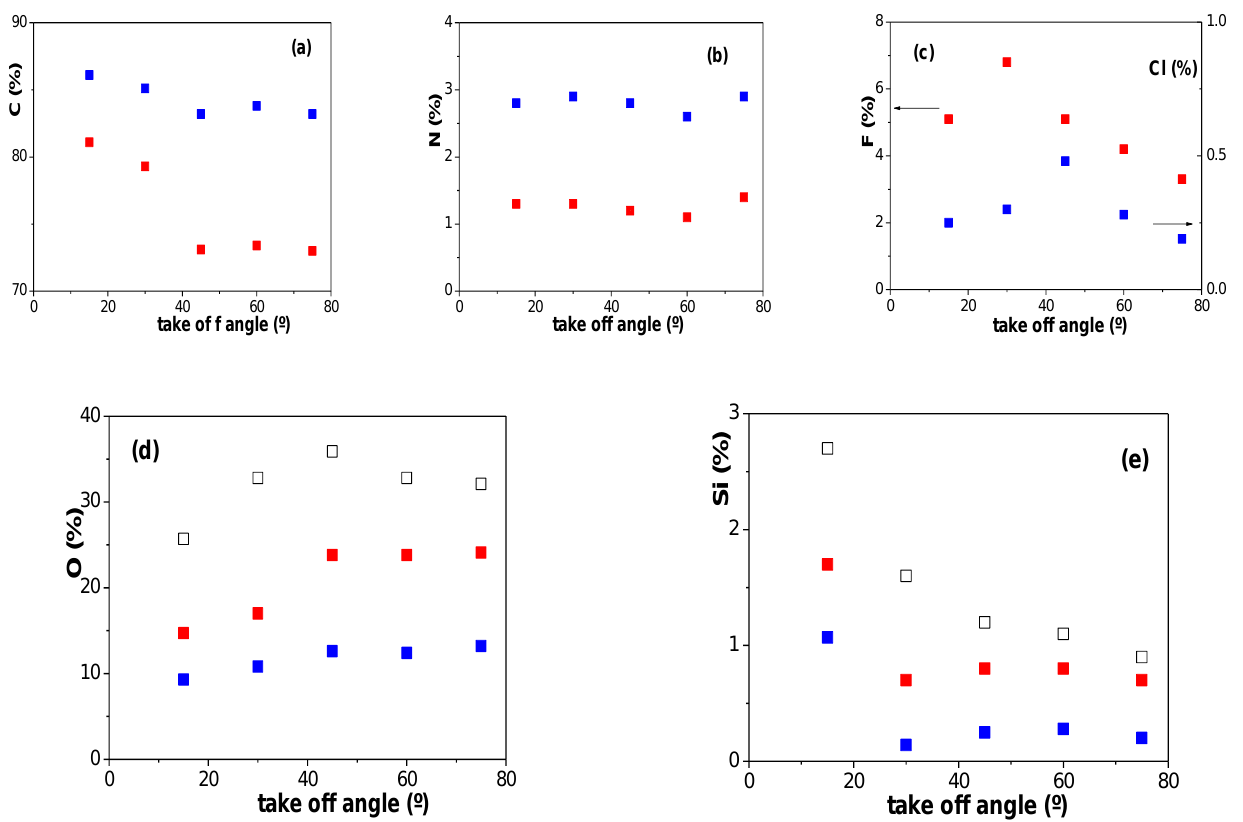
Figure 3. Variation with the take-off angle of A.C. % for: ( a ) carbon; ( b ) nitrogen; ( c ) fluorine or chlorine; ( d ) oxygen; and ( e ) silicon. RC/AliquatCl (blue solid points), RC/BMIMPF 6 film (red solid points). Black open points in ( d ) and ( e ) correspond to the RC support.